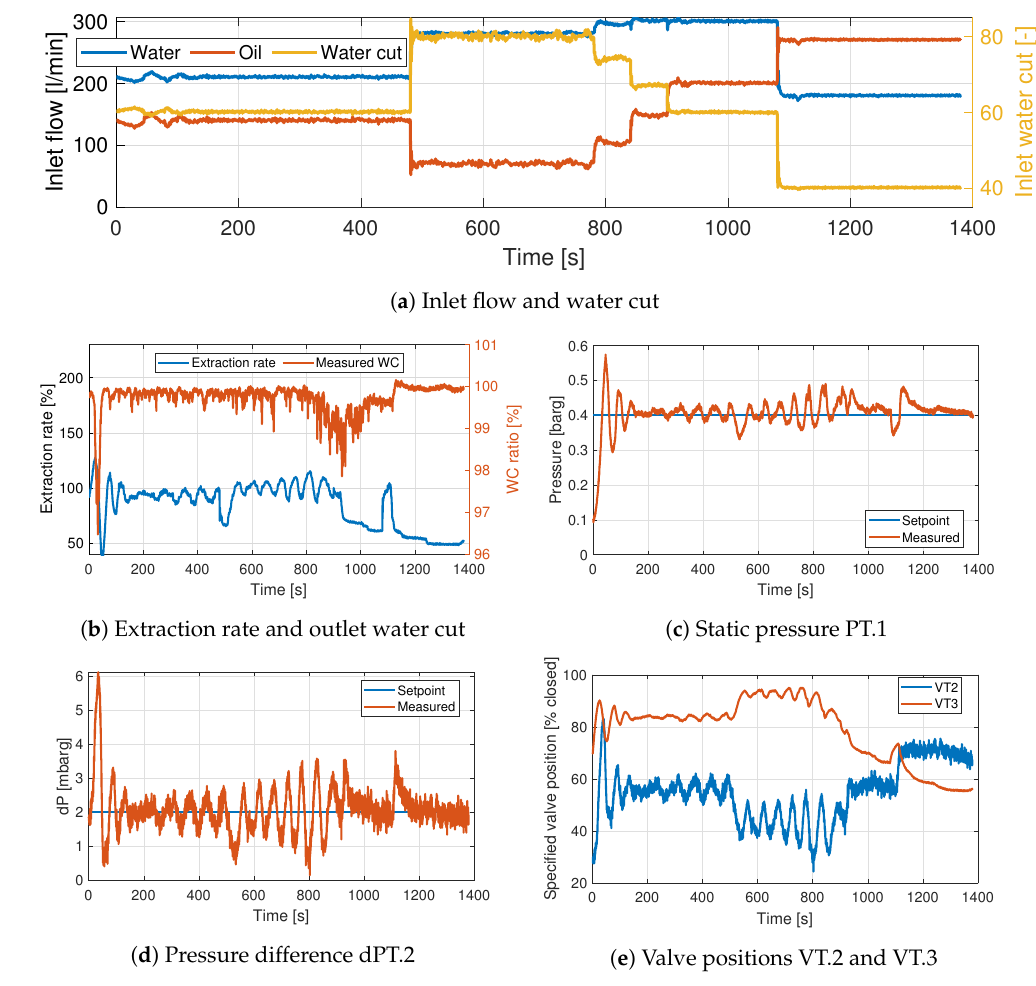
Figure 10. Experiment 4. PI controllers on VT.2 and VT.3 with VT.2 controlling dPT.2 and VT.3 controlling PT.1, as recommended by the RGA